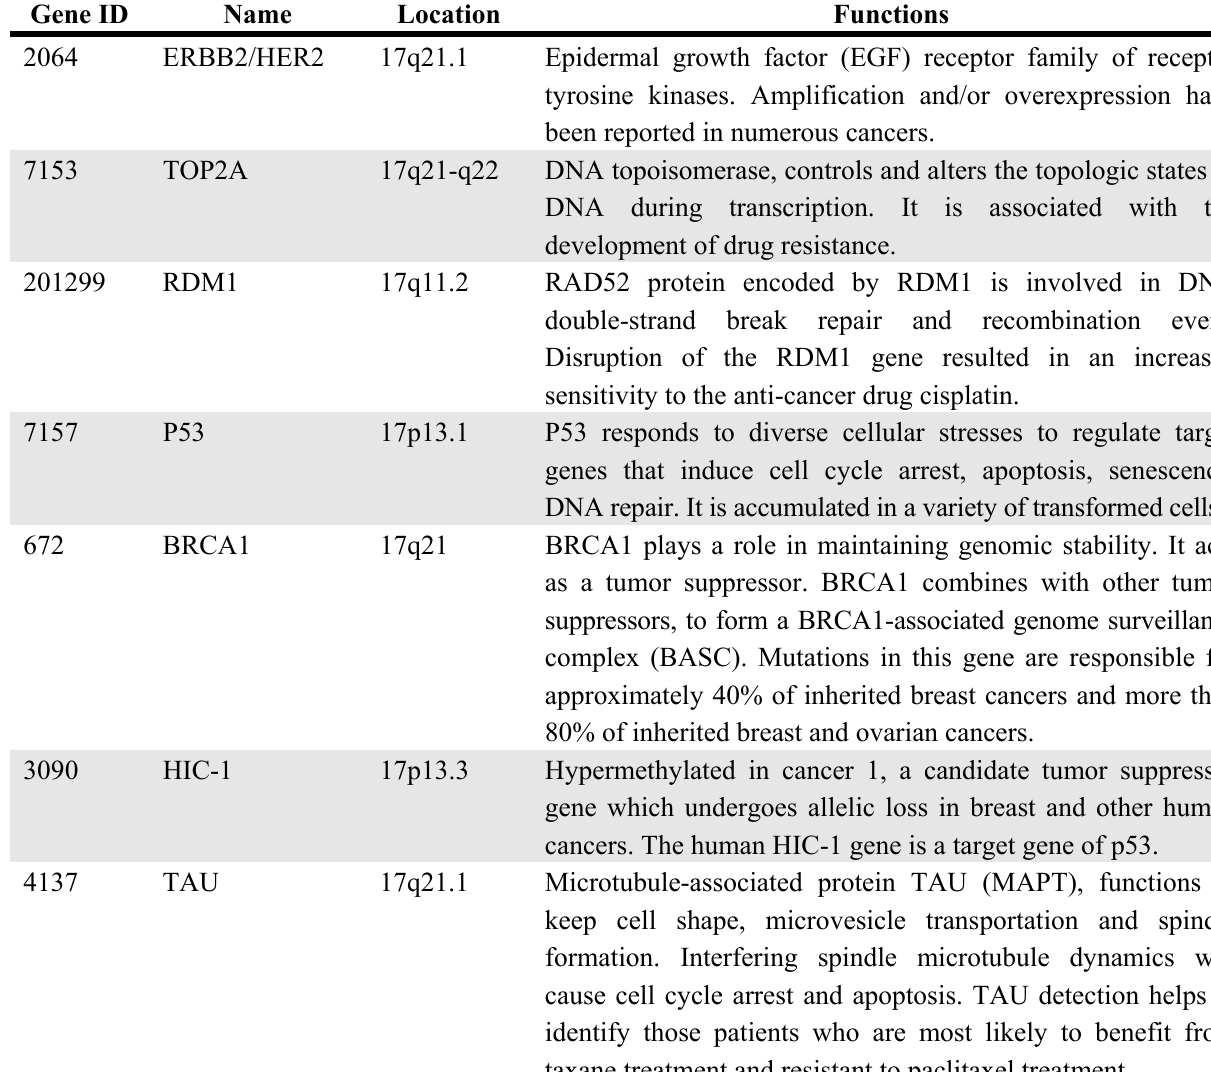
Table 1. Molecular markers and their functions on chromosome